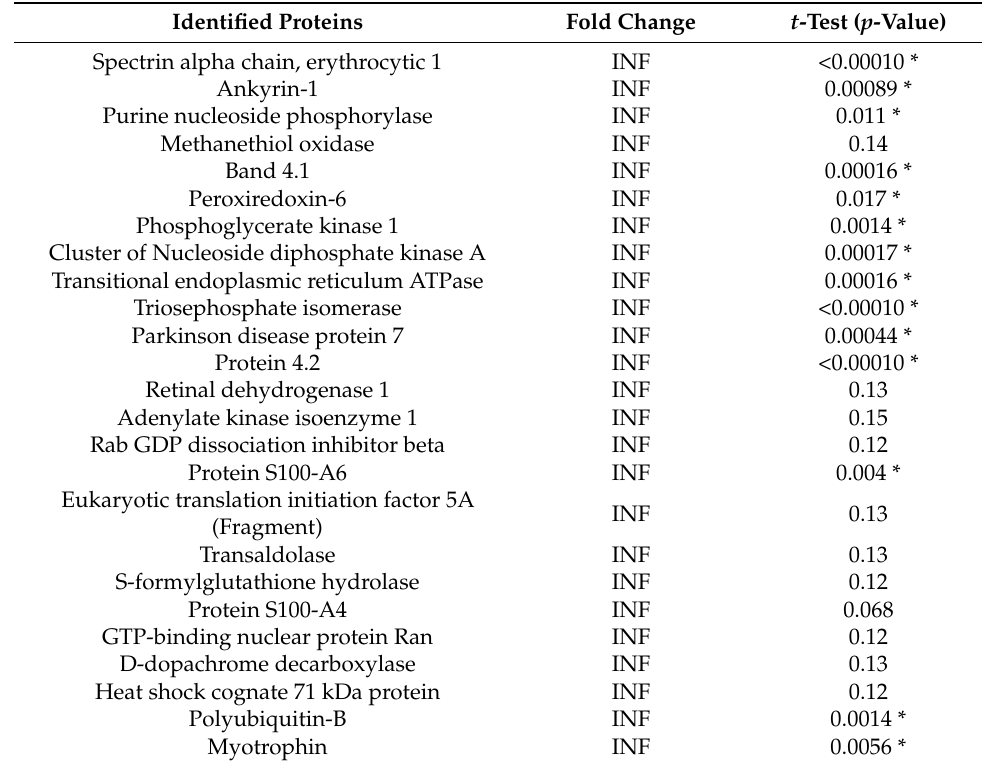
Table 1. Summary table of 25 most relatively abundant proteins identified in activated serum com- pared to whole blood after depletion of major blood proteins, such as albumin, immunoglobulins (A, D, E, G, G-light chain, and M), alpha-1-acid glycoprotein, alpha-1-antitrypsin, alpha-2-macroglobulin, apolipoprotein A1, fibrinogen, haptoglobin, and transferrin. T-test compared the fold changes be- tween the activated serum (AS) and whole blood samples. Infinite fold changes indicate that proteins in whole blood sample were below limit of